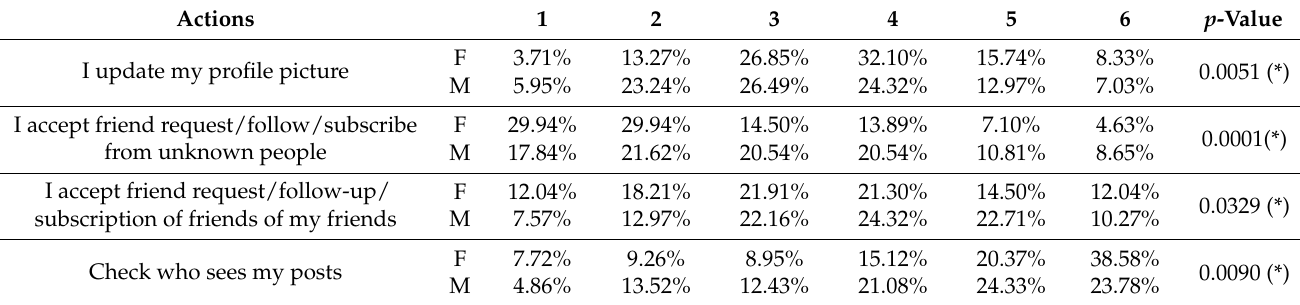
Table 7. Frequency with which they usually perform actions on the Web or social networks.